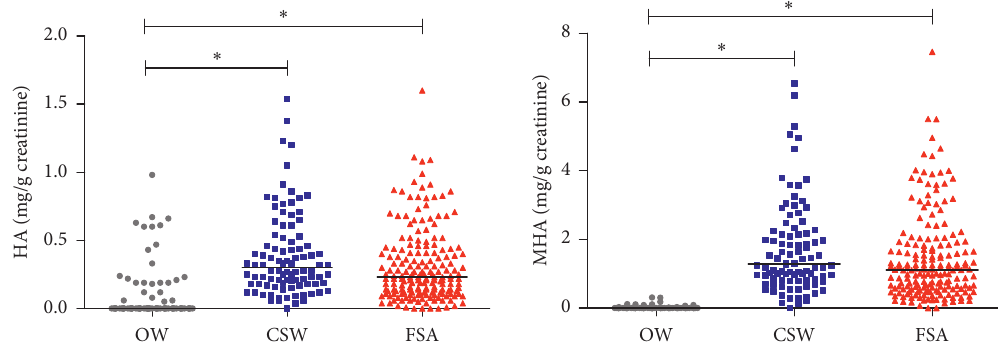
Figure 1: Scatter chart for values of hippuric acid and methylhippuric acid of gasoline station workers (occupationally exposed to VOCs) and office workers (comparison group) in Rio de Janeiro (Brazil), 2015–2017. Kruskal–Wallis test, p value < 0.001, with Dunn’s posttest, p value < 0.05.